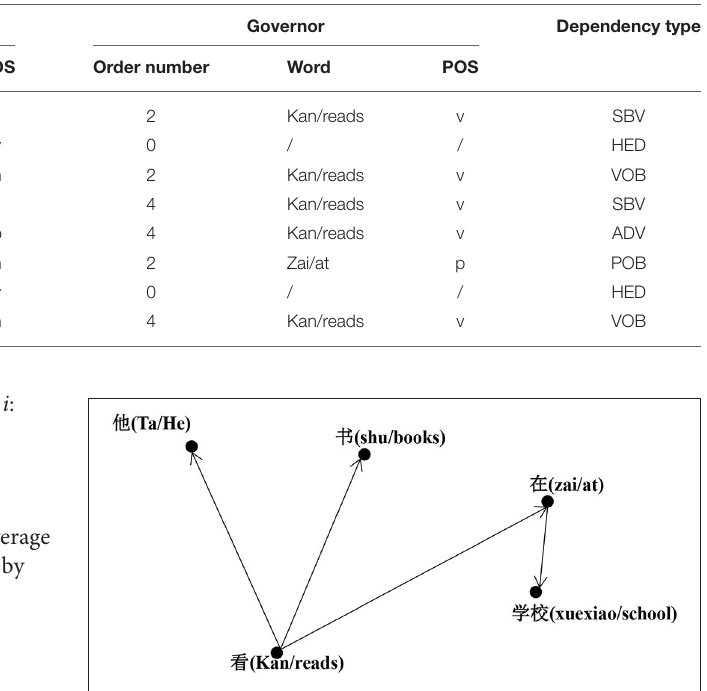
FIGURE 2 | The syntactic dependency network of two sentences Ta kan shu (“he reads books”) and Ta zai xuexiao kan shu (“he reads books at school”).